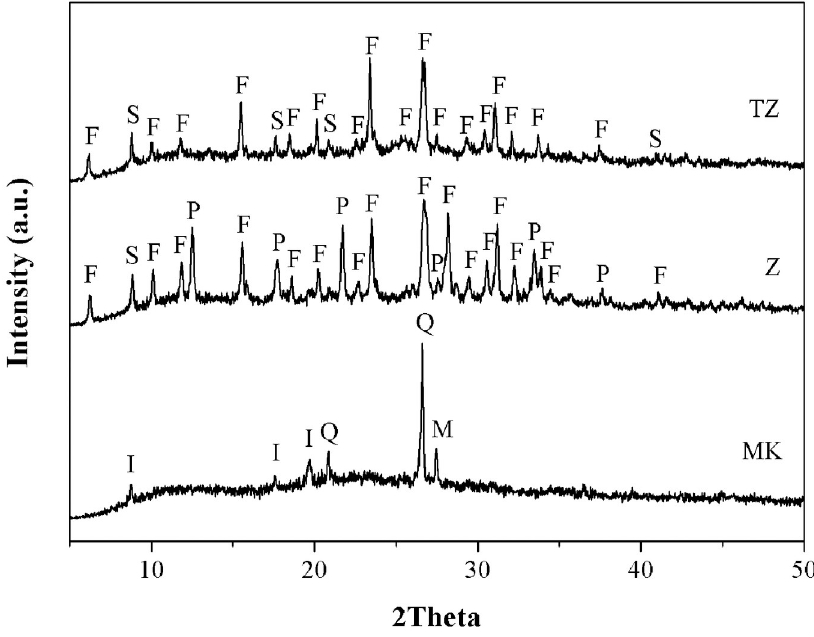
Fig 1. XRD patterns of starting materials. I; Illite, Q; Quartz, M; Microcline, F: Faujasite, P: Zeolite P1, S: Zeolite SSZ16.